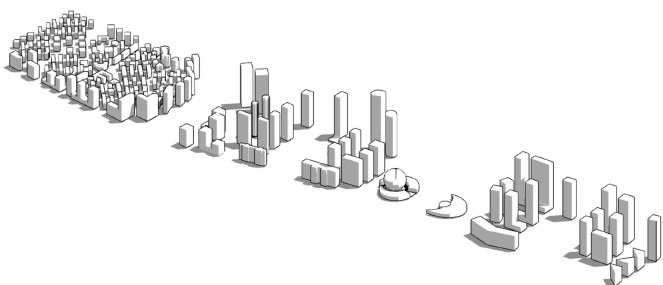
Figure 6. Model of Simulation area.